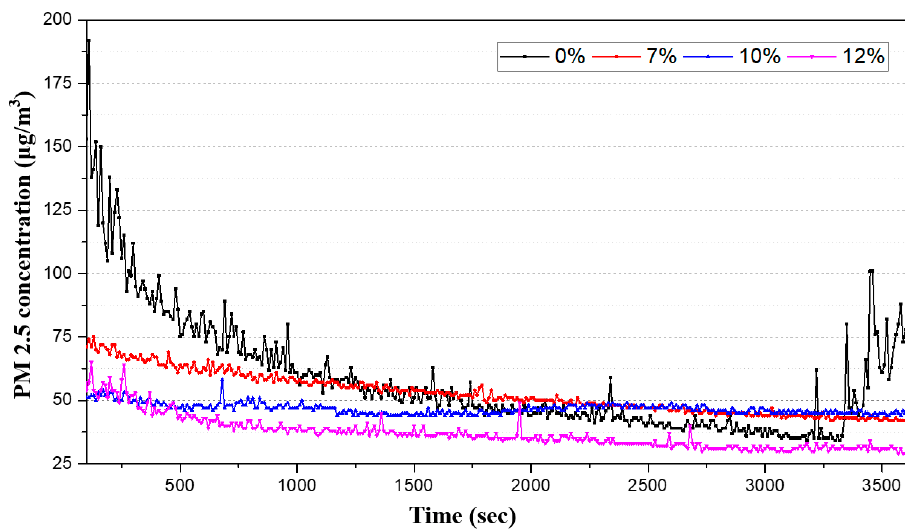
Figure 11. PM 2.5 dust generation for soil samples.